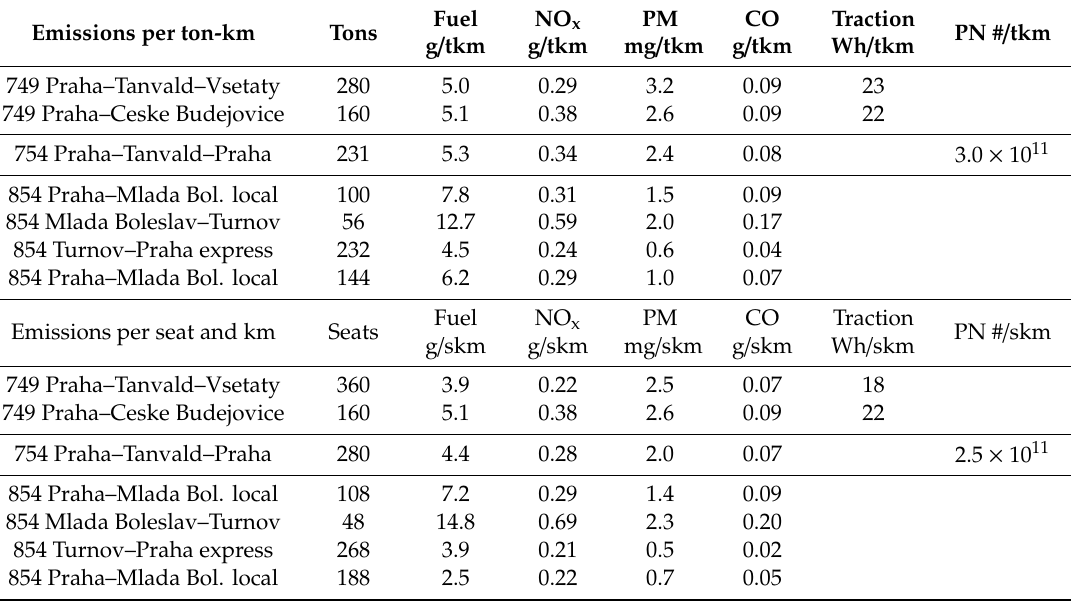
Table 4. Fuel consumption and emissions per ton-km and per